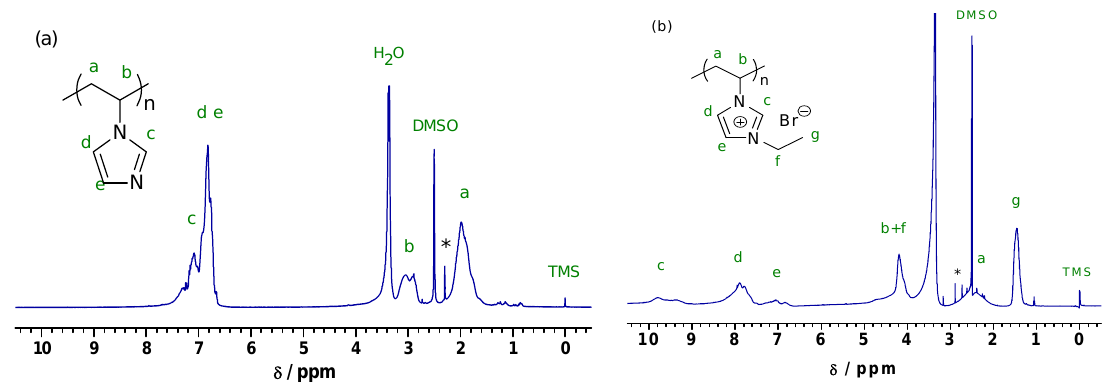
Figure 2. 1 H-NMR spectrum of PVI-TFSI in DMSO- d